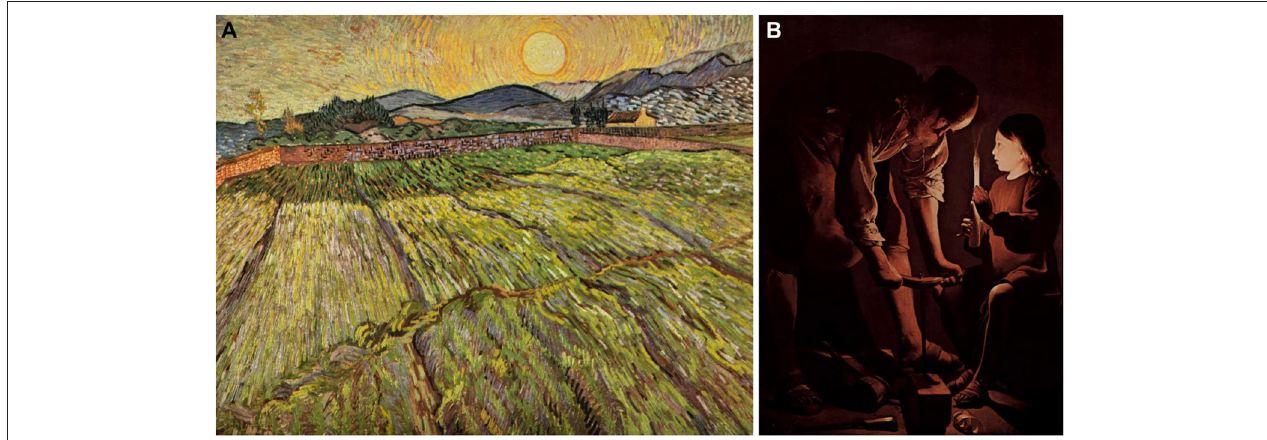
FIGURE 1 | (A) Painting “Enclosed field with rising sun” by Vincent van Gogh from the year 1889, explicitly showing the source of light—the sun. (B) Painting “Joseph the Carpenter” by Georges de La Tour from the approximate year 1645 explicitly showing the source of light—a candle. Both pictures and their reproductions are in the public domain (Creative Commons CC-BY